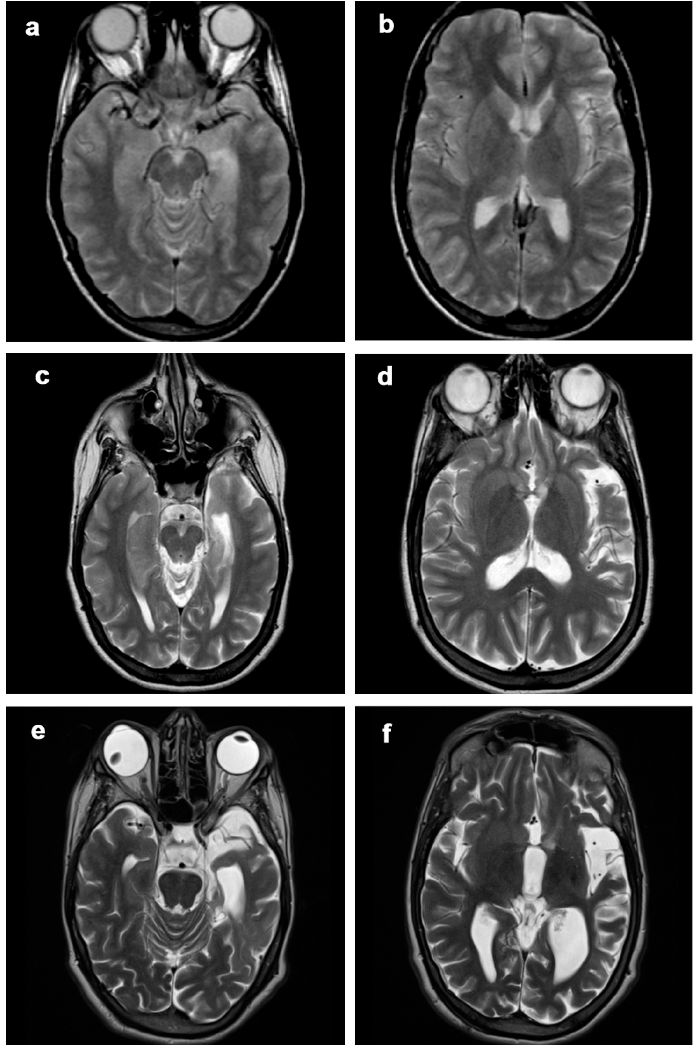
Figure 3. Patient 1, progression of the disease in 21 years. Axial ( a – f ) T2-weighted images at ( a , b ) 2 years, ( c , d ) 12 years and ( d , e ) 21 years from clinical onset. The disease slowly progressed over time, involving mainly frontobasal, insular, perisylvian and temporal left structures. At first MRI scan, only subtle atrophic changes could be seen in the perisylvian region ( b